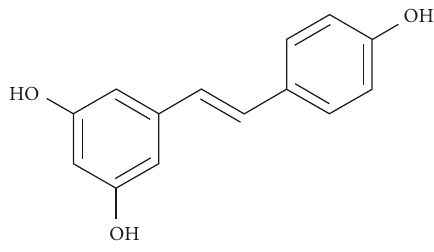
2: The schematic structure of the